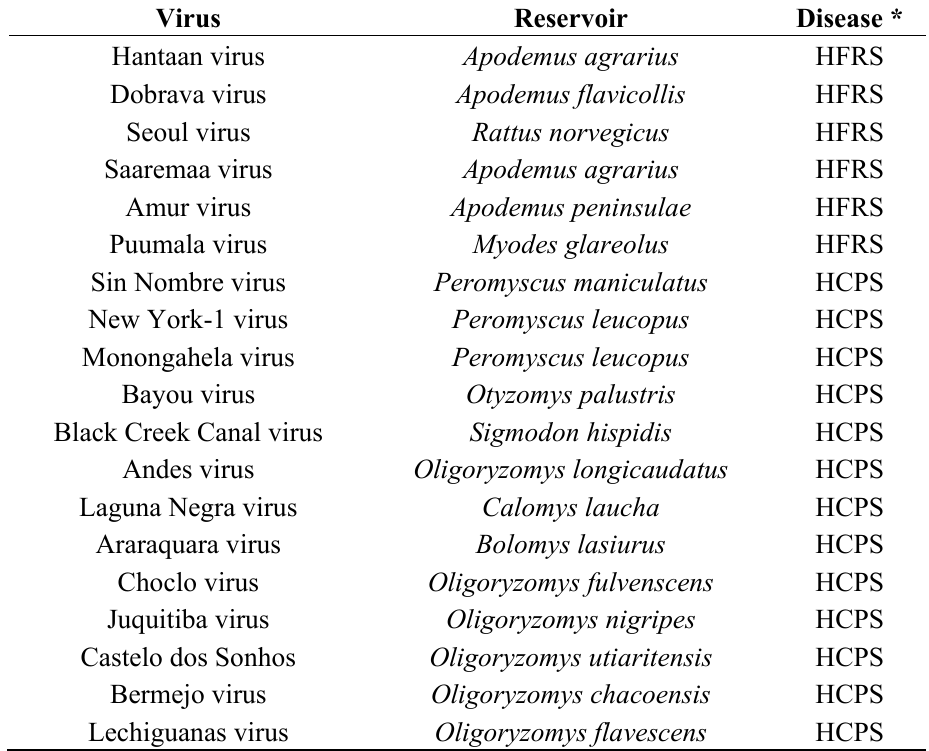
Table 1. Pathogenic hantaviruses and their principal reservoir